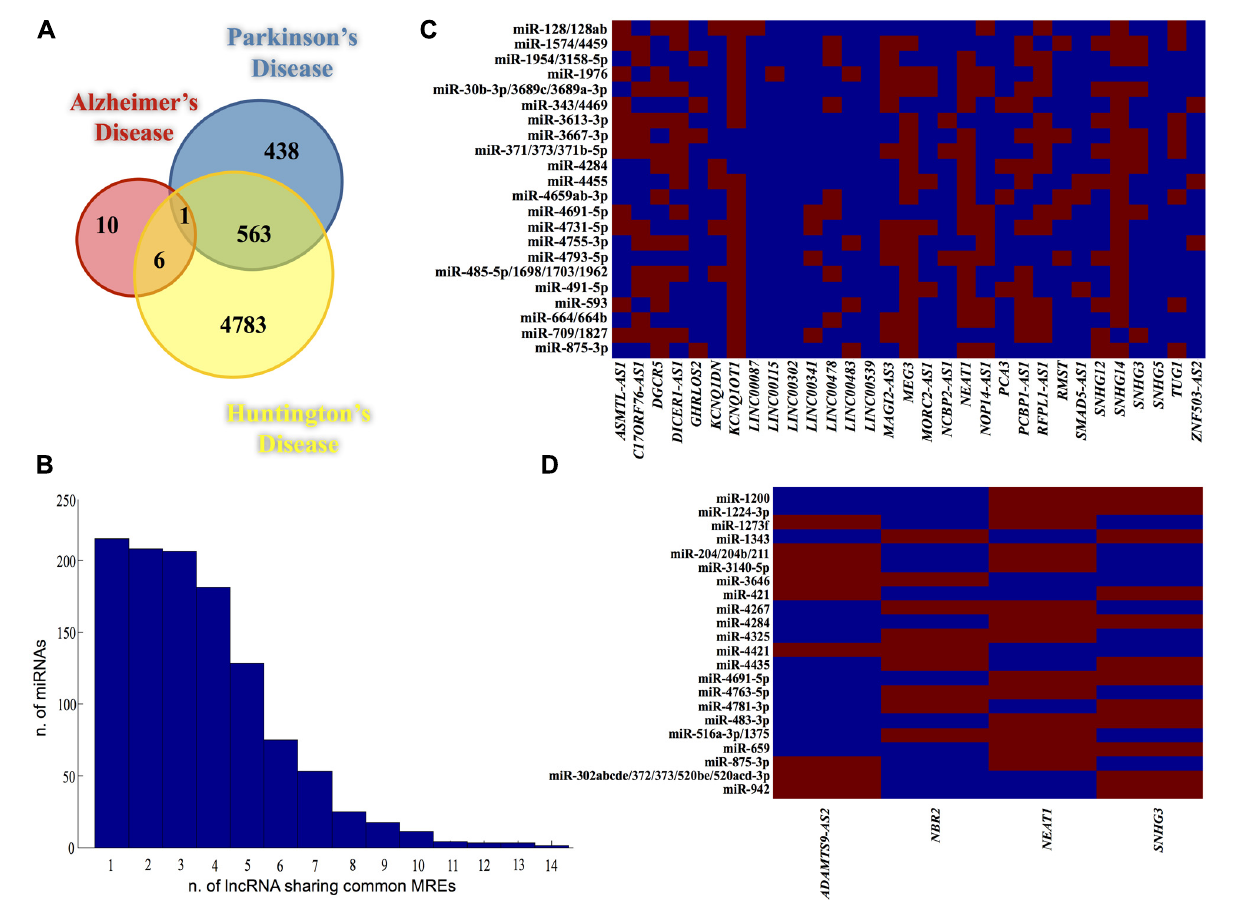
FIGURE 1 | (A) Venn diagram showing intersections of DE genes in all three NDs. Colored circles contain the number of genes per disease. (B) Bar graph showing the distribution of all the miRNAs binding sites ( y- axis) identified in lncRNAs DE in HD ( x -axis) which bind the same miRNA. Matrixes built with